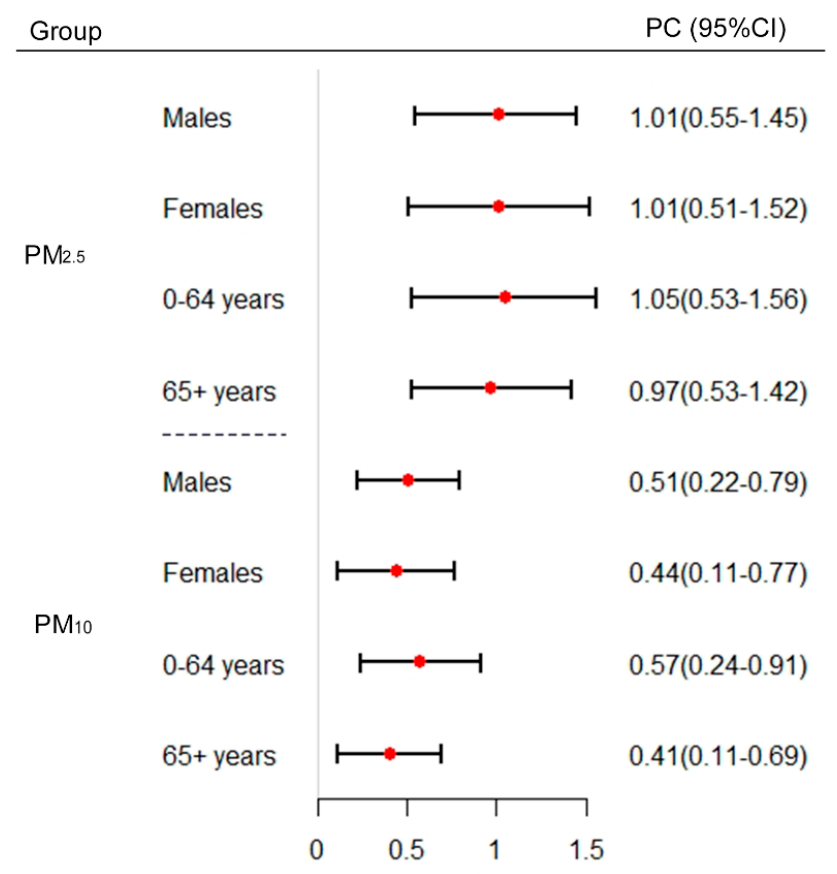
Figure 3. The estimated percent change of CVD hospitalizations per 10 µg/m 3 increase in PM 2.5 and PM 10 concentrations, by gender and age group. PC: percent change; CI: confidence interval.